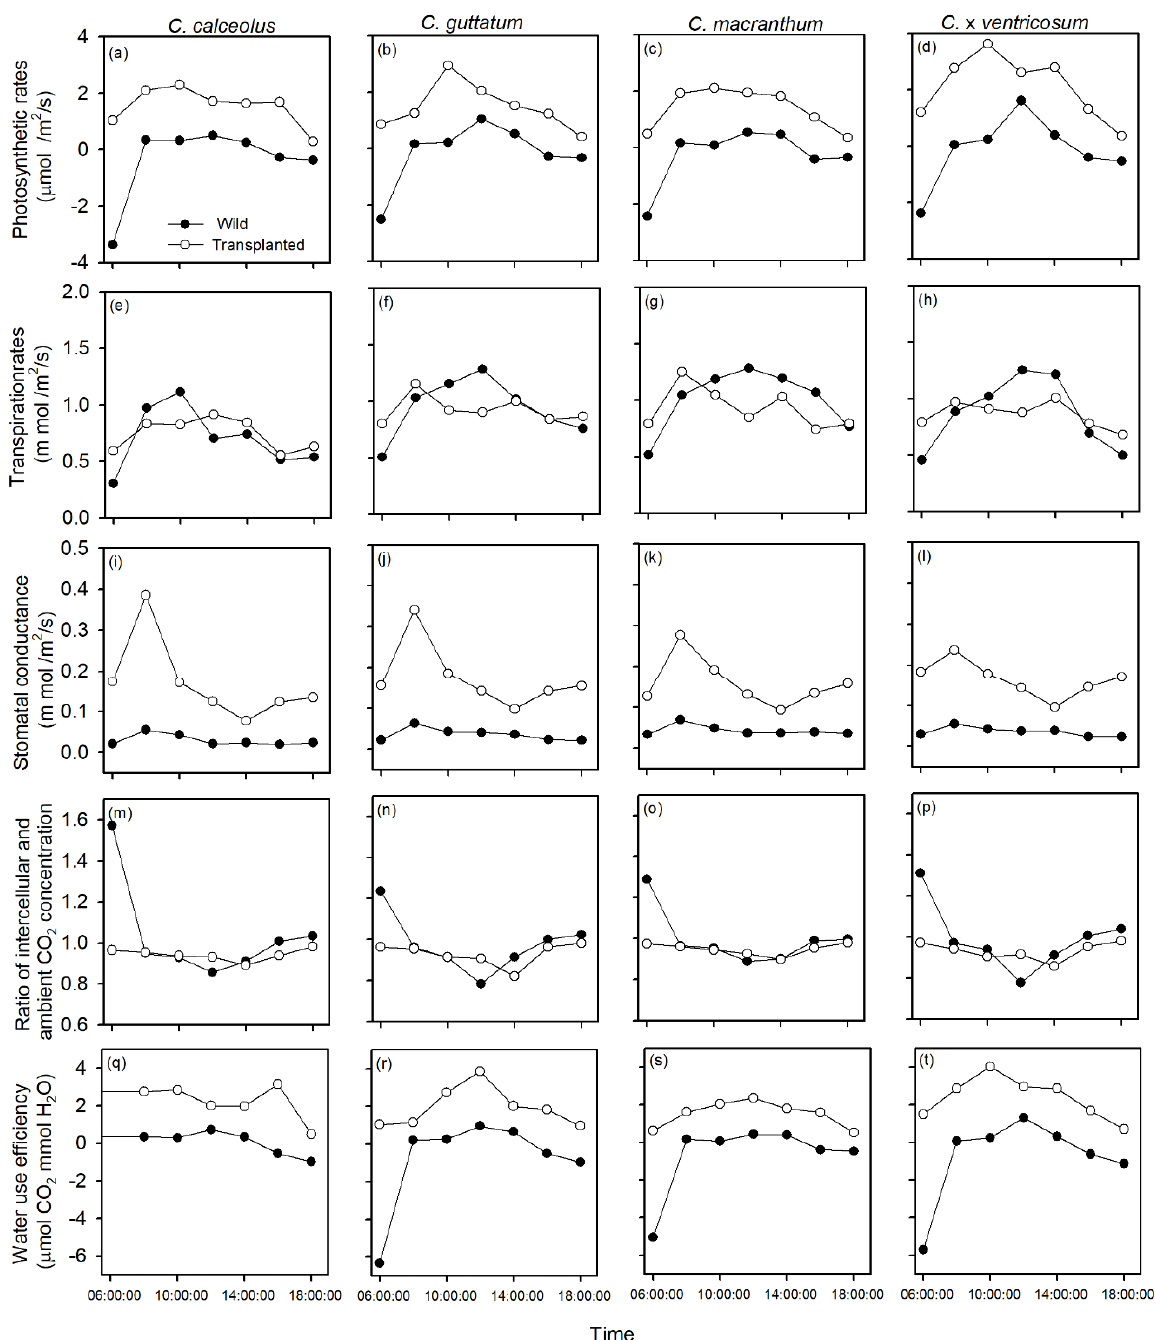
Figure 4. Diurnal changes in the photosynthetic rate ( a – d ), transpiration rate ( e – h ), stomatal conductivity ( i – l ), ratio of intercellular and ambient CO 2 concentration ( m – p ) and water use efficiency ( q – t ) of four wild and transplanted Cypripedium species, respectively.